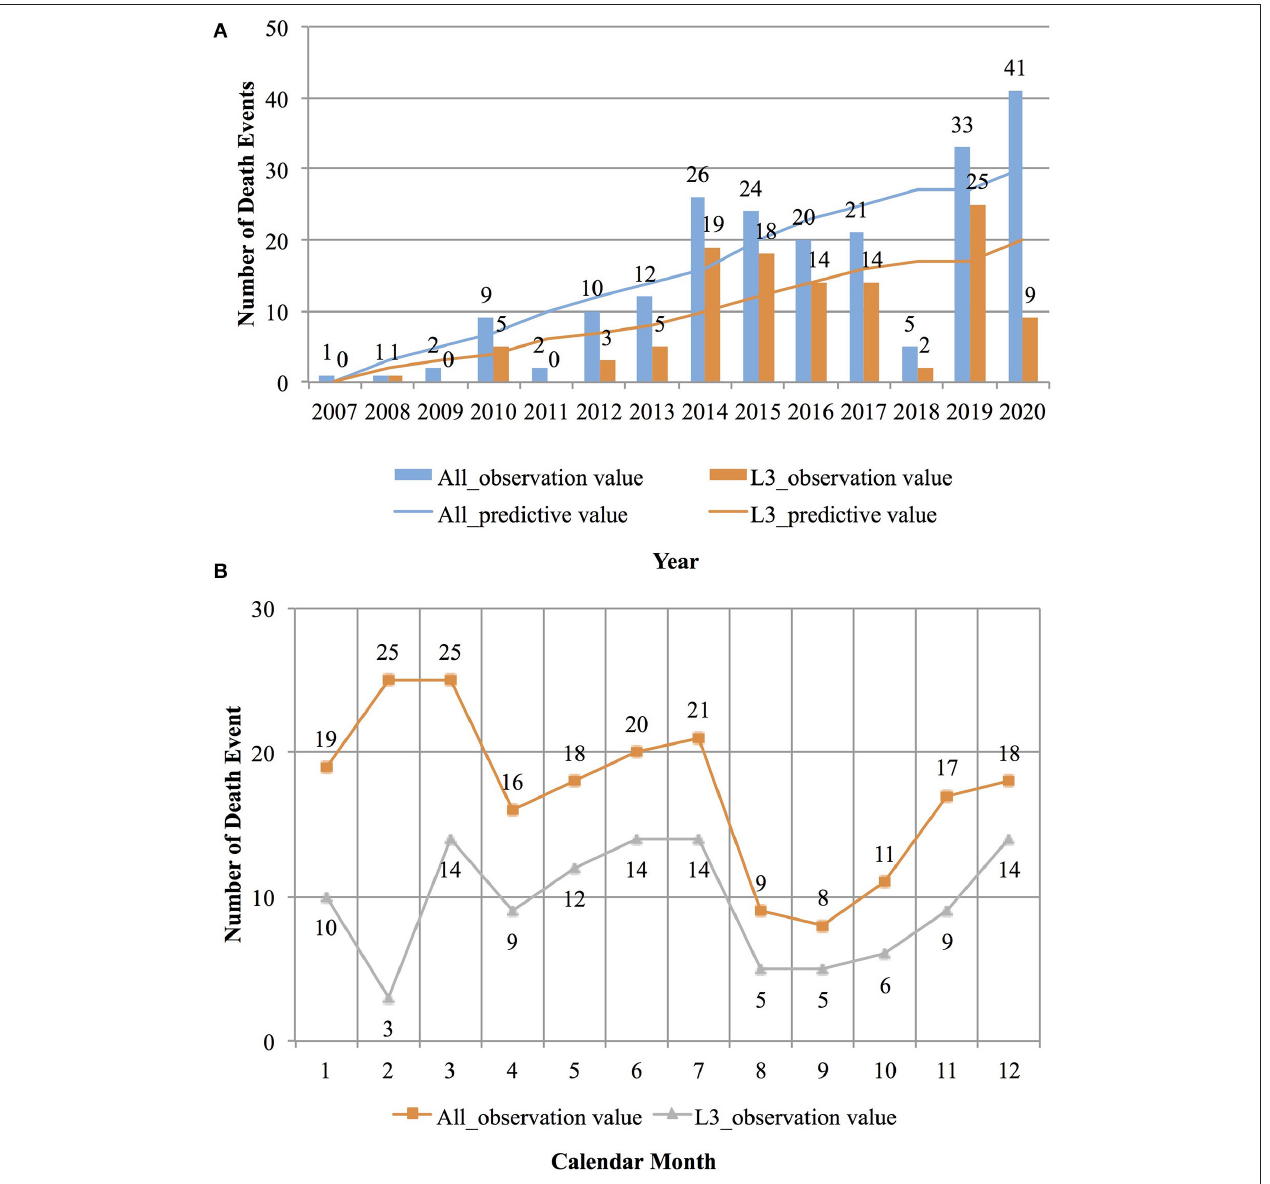
FIGURE 2 | The distribution of abnormal deaths of doctors over time. (A) The distribution of the number of abnormal deaths of doctors by years. (B) The distribution of the number of abnormal deaths of doctors by months.